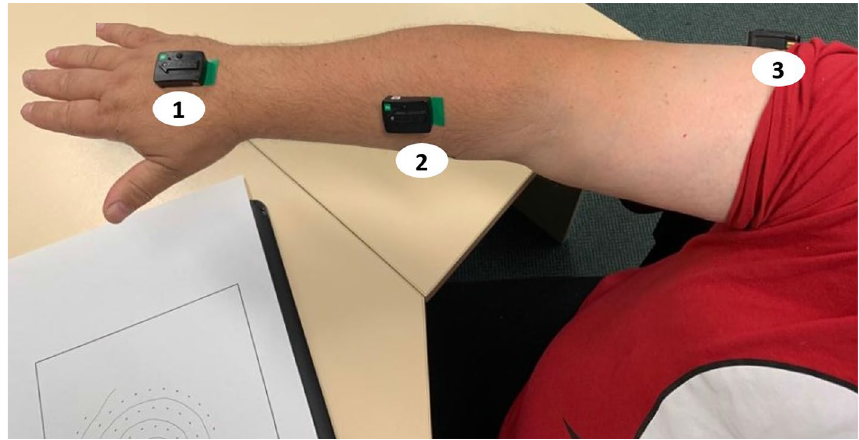
Figure 5. Participant performing the spiral drawing task with the wearable sensors mounted on the upper limb.